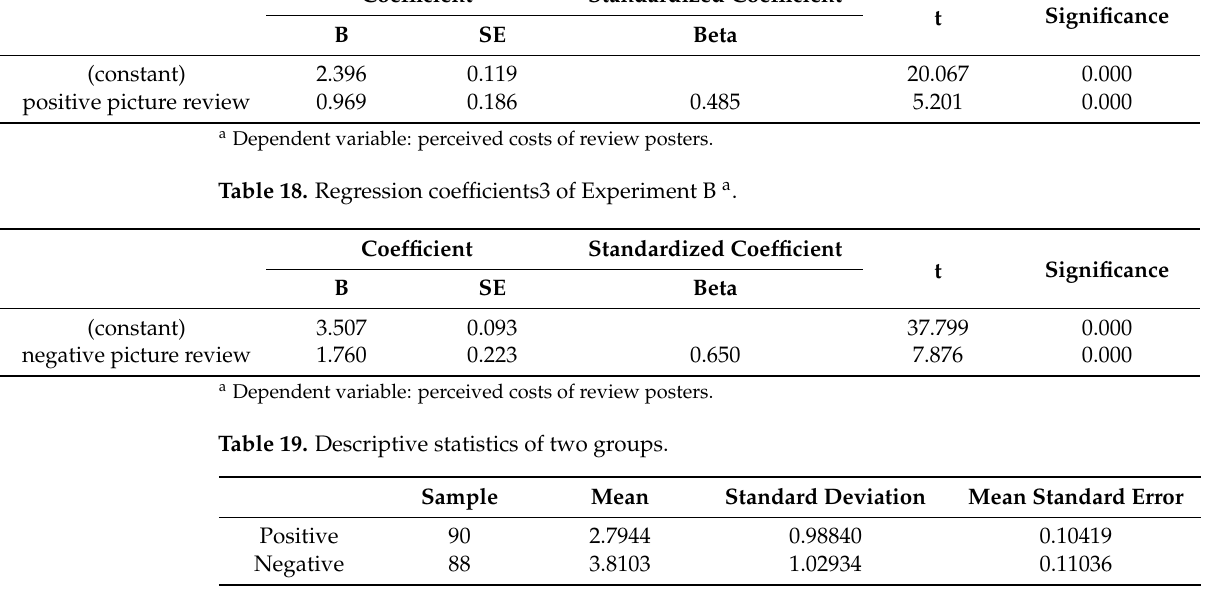
Table 20. Results of independent samples’ t